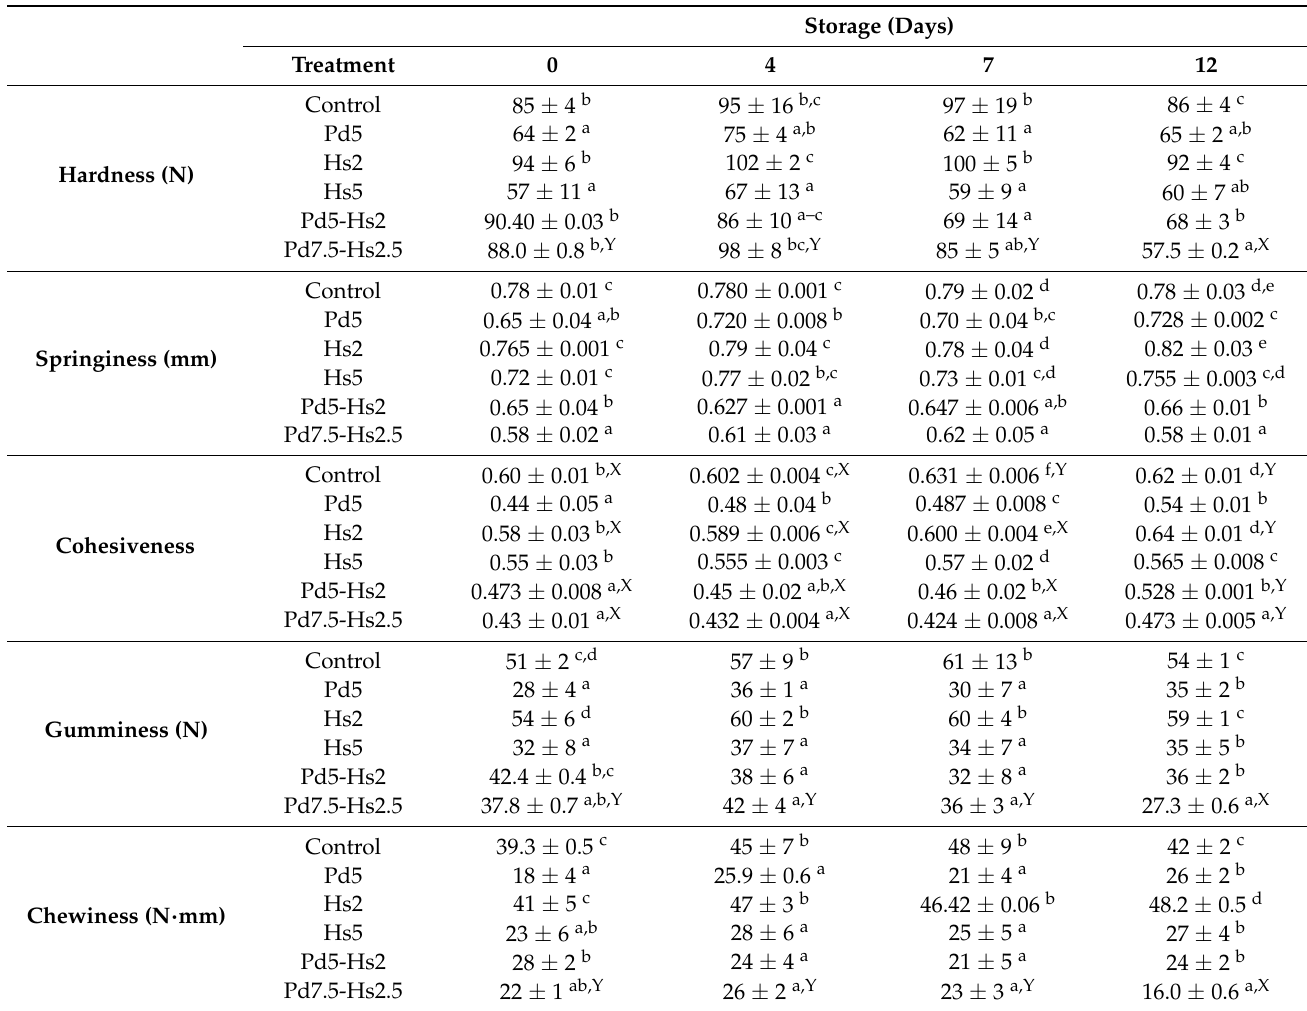
Table 5. Texture parameters of beef